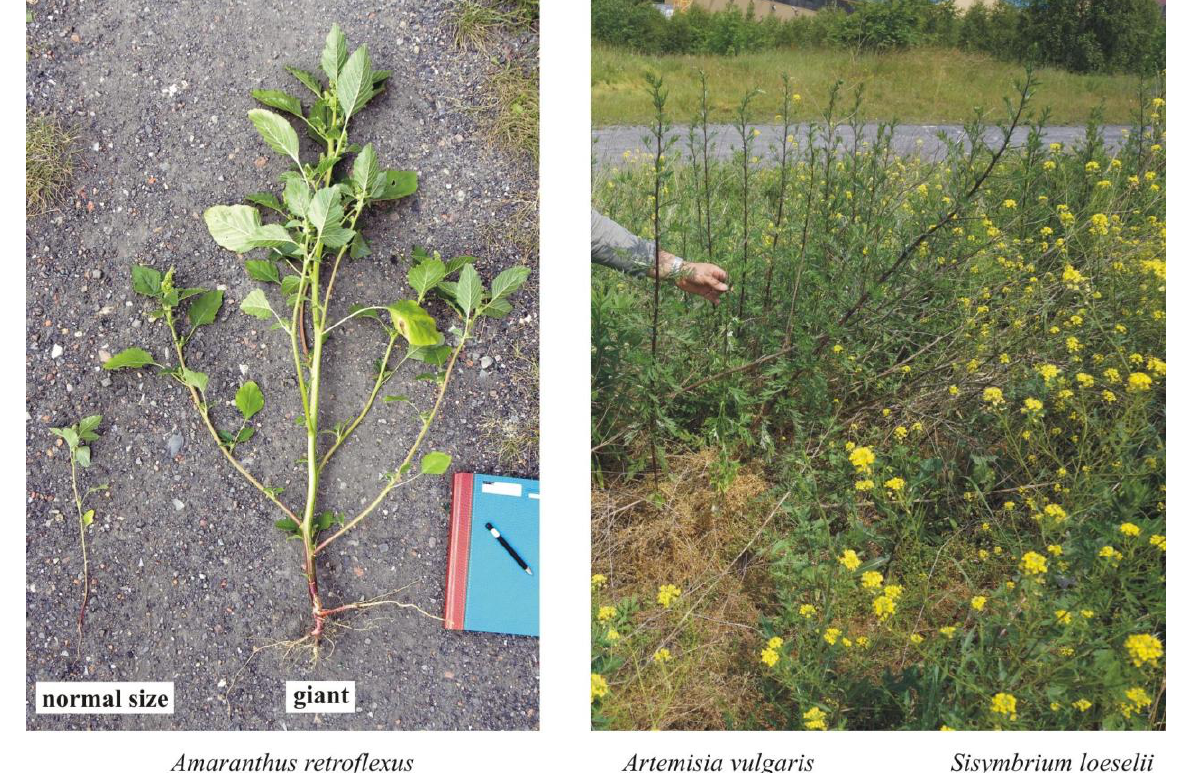
Fig. 5. Examples of gigantism from the Katowice-Wełnowiec dump (J.